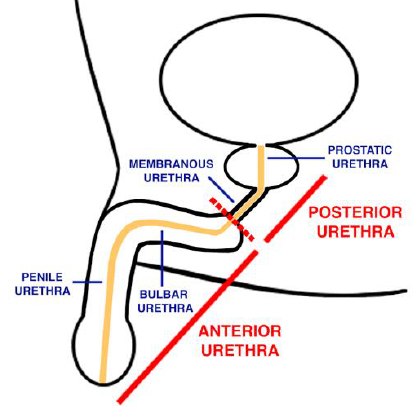
Figure 1. Basic urethral anatomy.